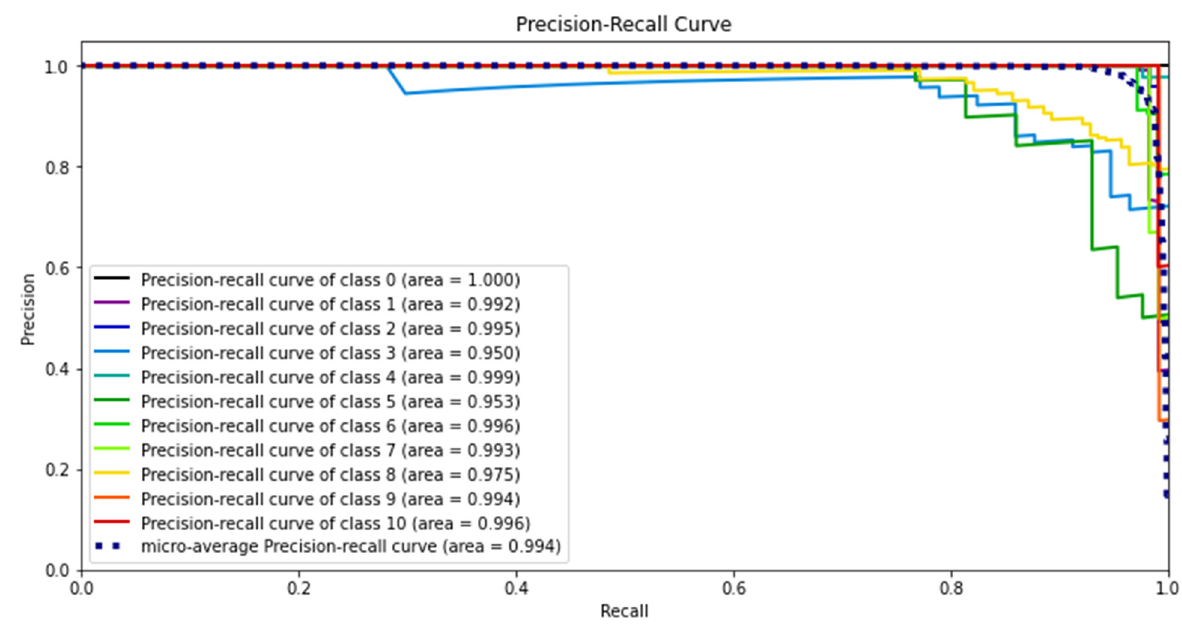
Figure 12. Precision–recall curve of the SVM with the RBF classifier on version 1 of the dataset. Table 8. Memory utilization of the machine learning classifiers on version 1 of the dataset.